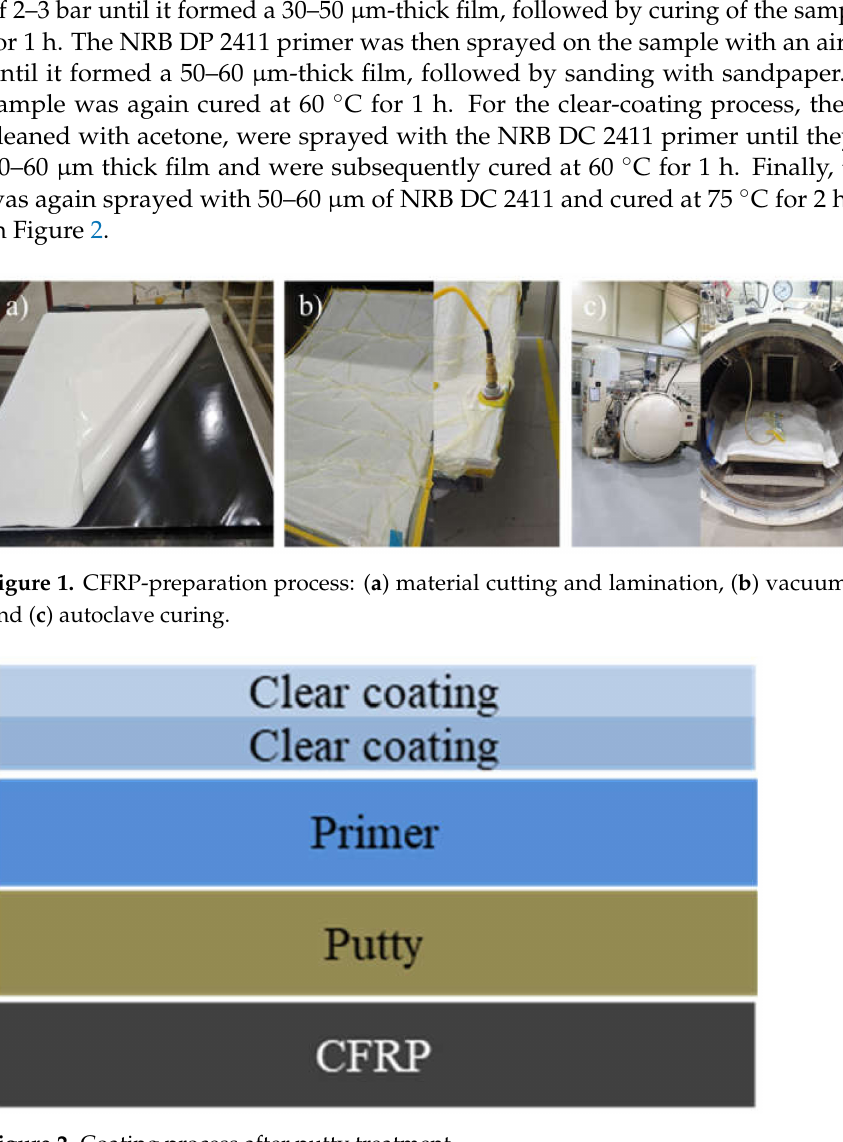
Figure 2. Coating process after putty treatment.